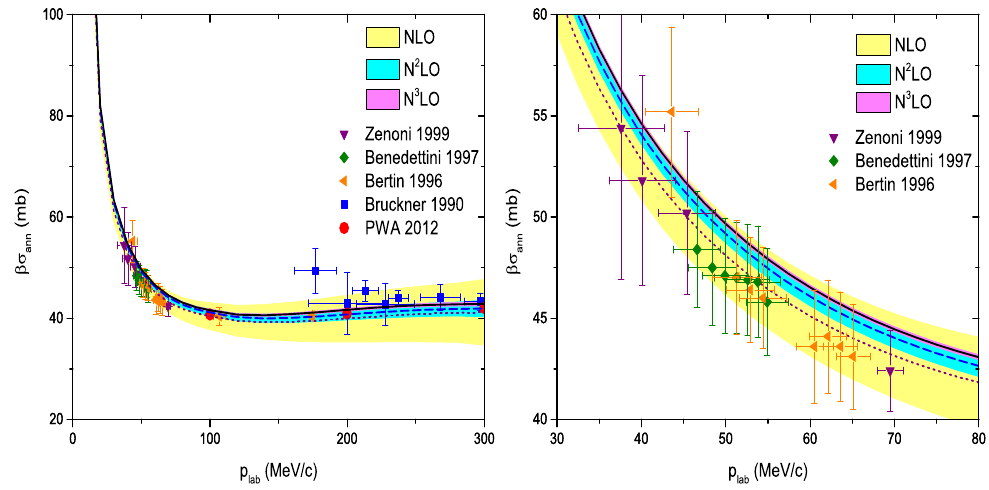
Figure 14 . (cid:22) pp annihilation cross section multiplied by the velocity (cid:12) of the incoming (cid:22) p . Notations are described in the text. The results of the PWA [32] are indicated by circles. Data are taken from [104{107].